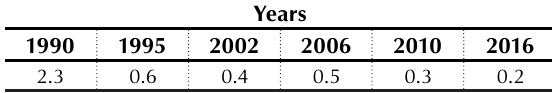
Table 3. Dynamics of reduction in high-tech products financing from the State Budget of Ukraine, in % as to GDP